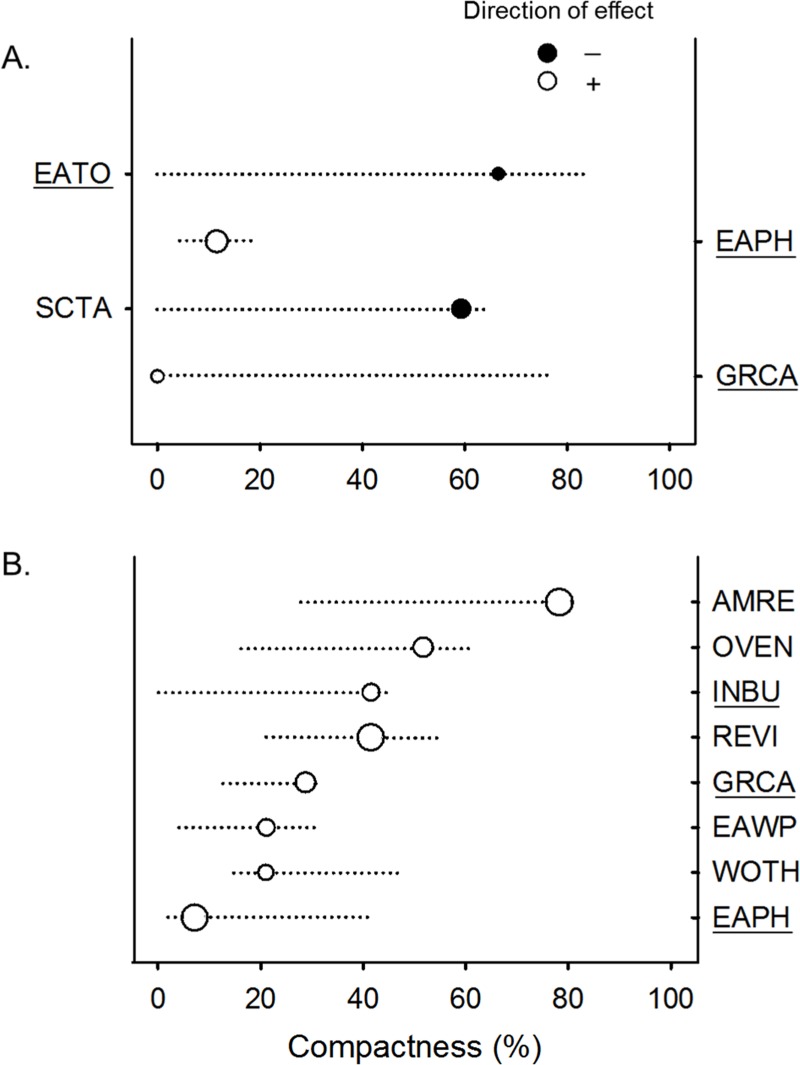
Change points of significant (p < 0.05) and reliable (purity ≥ 0.90 and reliability ≥ 0.90) indicator bird species of compactness of exurban development for (A) 400-m and (B) 1-km radius buffer around selected BBS stops.Solid circles represent negative response to compactness (with corresponding species on the left axes) and open circles correspond to a positive response (with corresponding species on the right axes). Circles are sized based on z scores and lines represent the 5 and 95% percentiles among bootstrap replicates. Short lines indicate nonlinear response, whereas long lines represent linear or more gradual response. Taxa IDs correspond to American Redstart (AMRE), Eastern Wood-Pewee (EAWP), Ovenbird (OVEN), Red-eyed Vireo (REVI), Scarlet Tanager (SCTA), Wood Thrush (WOTH), Eastern Phoebe (EAPH), Eastern Towhee (EATO), Gray Catbird (GRCA), Indigo Bunting (INBU), and Northern Cardinal (NOCA). Underlined codes denote forest-edge species.